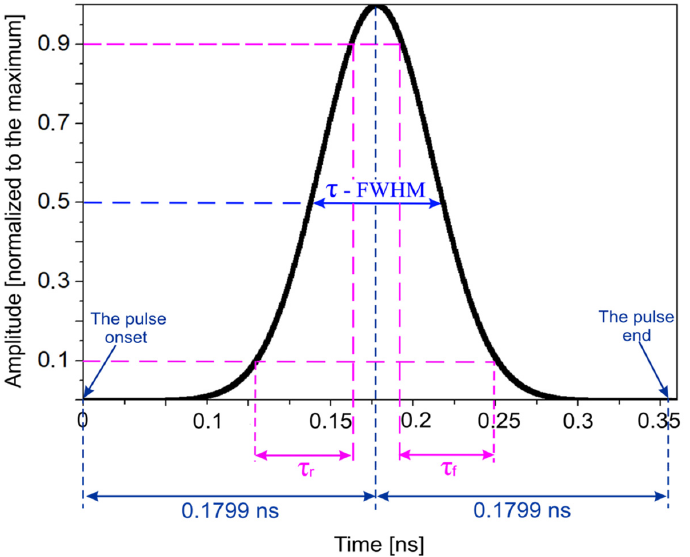
Figure 2. The time dependence of the electric field strength (or the magnetic field strength) of the normalized incident Gaussian EM plane wave